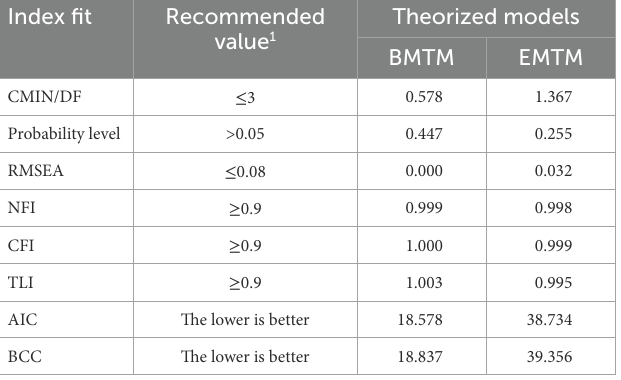
TABLE 2 Hypothesized models evaluation by goodness-of-fit